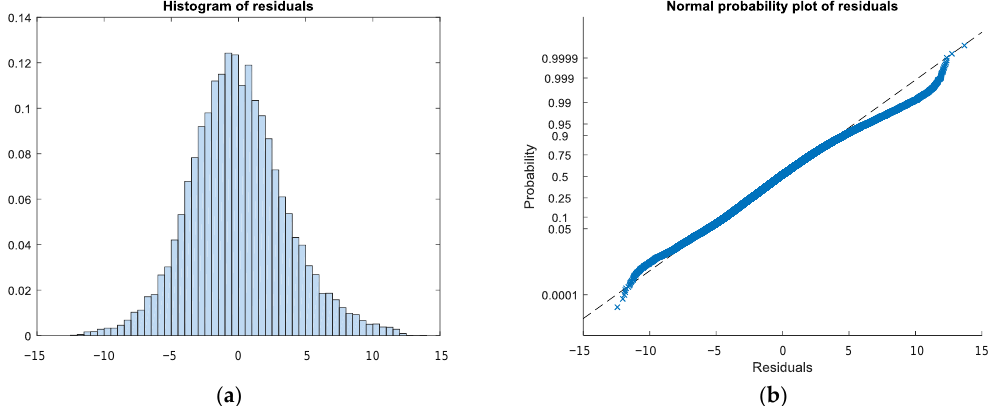
Figure A2. Plot of residuals for the modified linear model. ( a ) Histogram of residuals; ( b ) Probability plot of